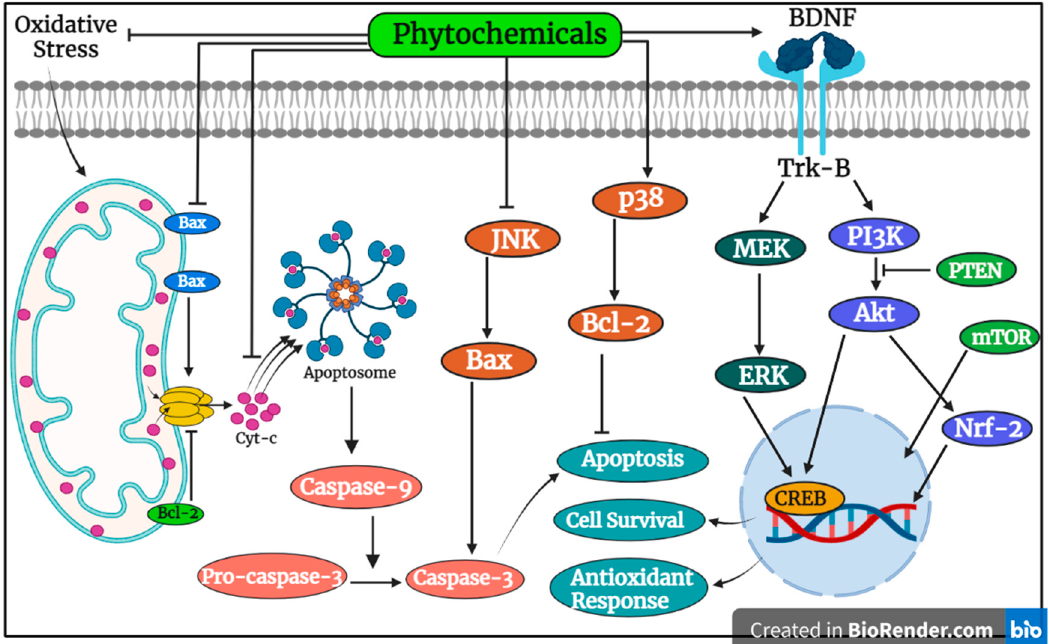
Figure 1. Apoptosis is triggered through the activation of intrinsic as well as extrinsic pathways involving modulation of several pro- and anti-apoptotic proteins. Phytochemicals can up-regulate anti-apoptotic proteins such as Bcl-2 while down-regulating expression of pro-apoptotic proteins, including bax, cytochrome-c, caspase-9, and caspase-3, in neurodegenerative diseases. Phyto- chemicals also enhance the expression of pro-survival-related proteins as well as Nrf-2, which leads to antioxidant response.